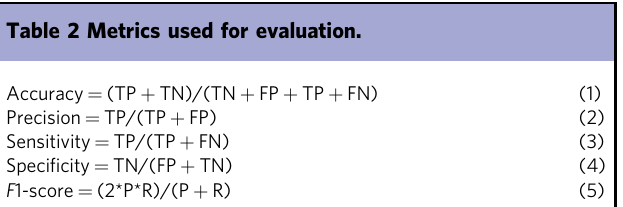
Table 2 Metrics used for